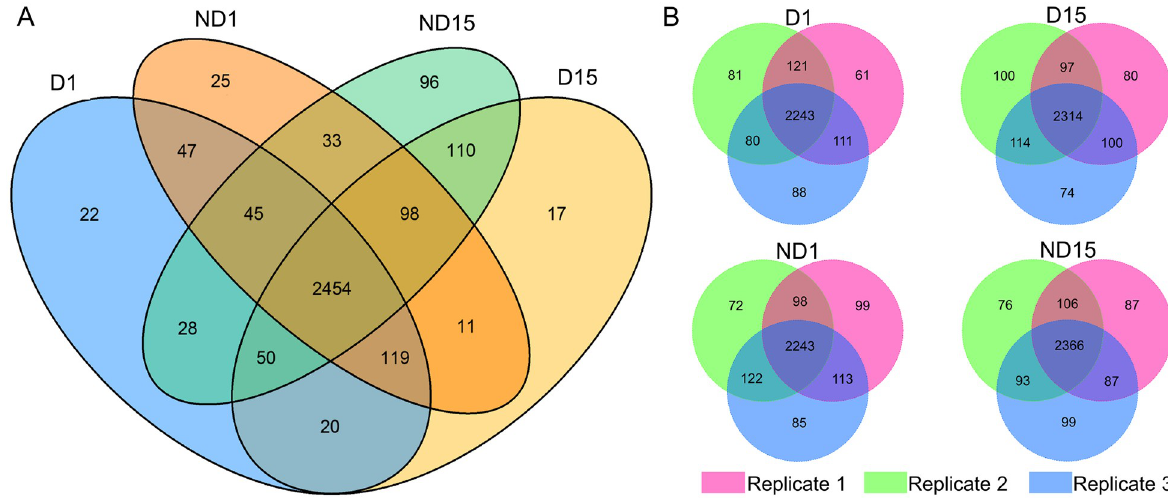
Fig 2. Venn diagram of proteins identified from non-diapause-(ND) and diapause-destined (D) pupae of Bactrocera minax . (A) Number of proteins identified from D1, D15, ND1, and ND15. The proteins identified from at least one of three replicates were shown in the diagram. (B) Number of proteins identified from three replicates in D1, D15, ND1, and ND15, respectively.